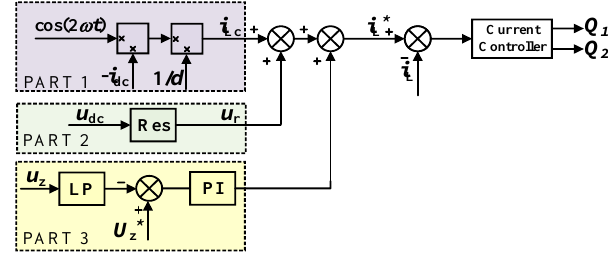
Figure 4. Control block diagram of the power decoupling circuit.